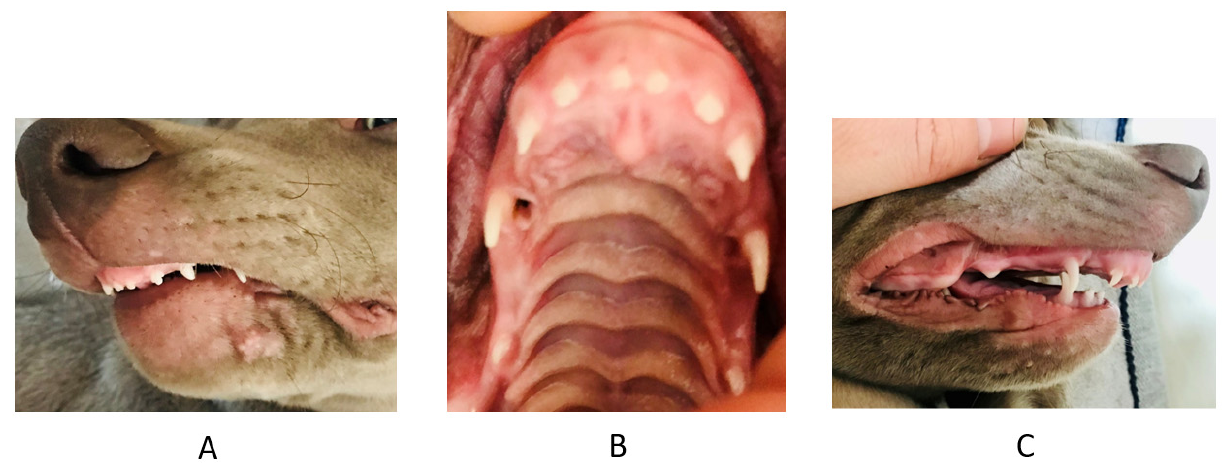
Figure 8. Third case. Extraoral and intraoral photographs at deciduous dentition stage. ( A ) left side, ( B ) palate, ( C ) right side.